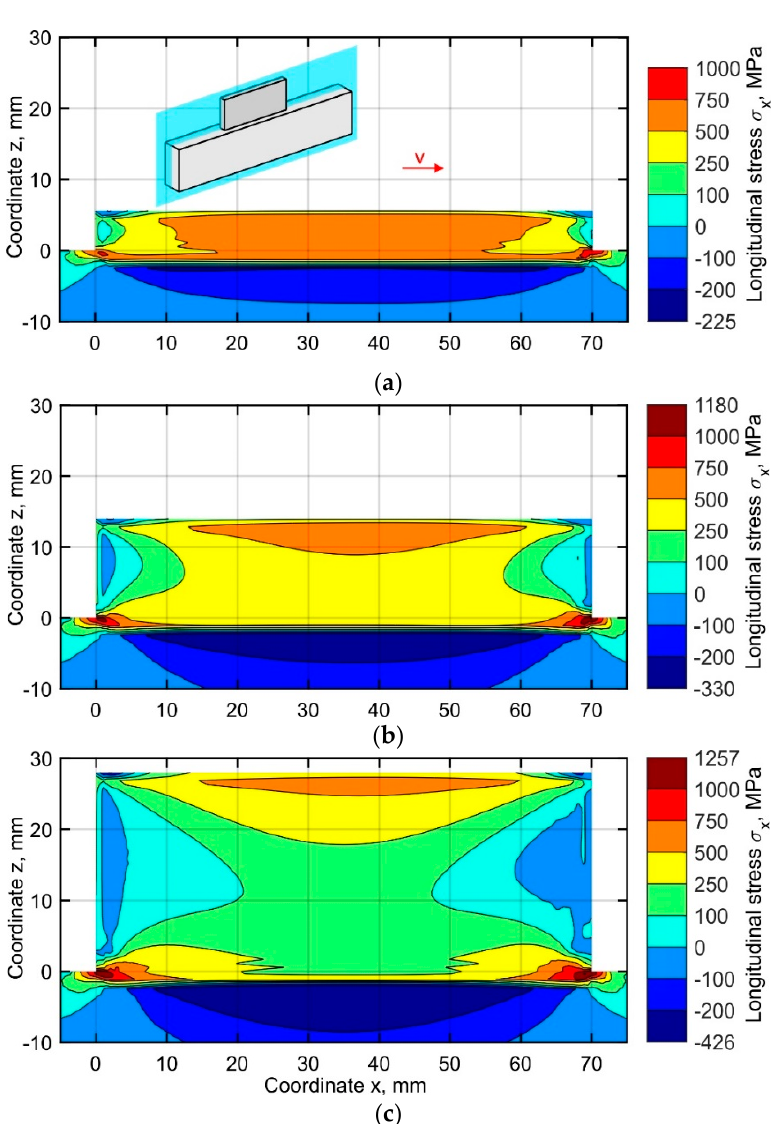
Figure 8. Longitudinal stress distribution in the central longitudinal-section of the buildup at the time corresponding to the end of the cooling after ( a ) 10, ( b ) 25 and ( c ) 50 layers. The distribution of the normal stresses σ z through the buildup thickness shows a similar trend. In the middle section, a significant stress non-uniformity is observed as shown in Figure 11d–f. The compressive stress reaches up to 478 MPa near the side surfaces of the buildup. The maximum difference in the stresses along the thickness direction is found near the substrate. Hence, the stress difference between the center and the side surface is 326 MPa at a distance of 2 mm from the substrate, see Figure 11f. On the other hand, a uniform distribution of the normal stress σ z over the thickness of the buildup is observed in the section near the left end (Figure 11a–c), which is similar to the case of the longitudinal stress σ x